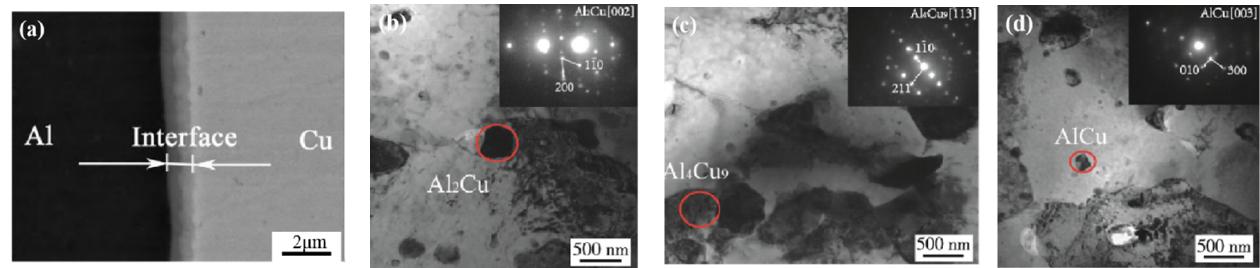
Figure 16. ( a ) Microscope image of a typical IMC (adapted from [3], with permission from Elsevier, 2010); ( b ) Al 2 Cu [002] phase; ( c ) Al 4 Cu 9[113] phase; ( d ) AlCu [003] phase (adapted from [62], with permission from CNKI, 2019).